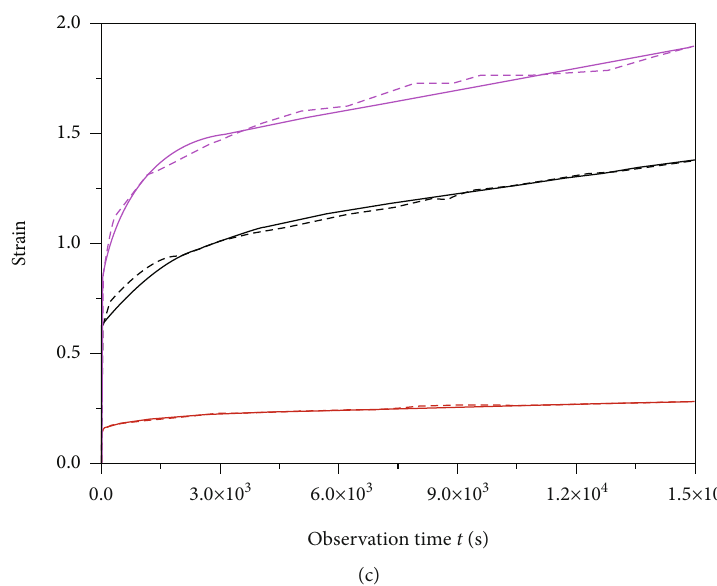
= 1 min , (b) t = 13 min , and (c) t = 250 min . f f f